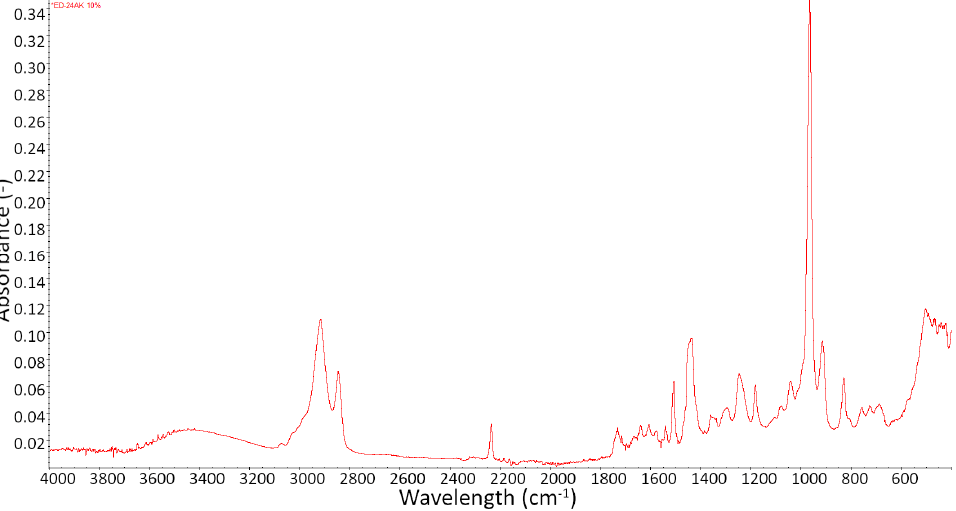
Figure 11. FT-IR spectrum of NBR modified with 10 wt.% ED-24AK after vulcanization.